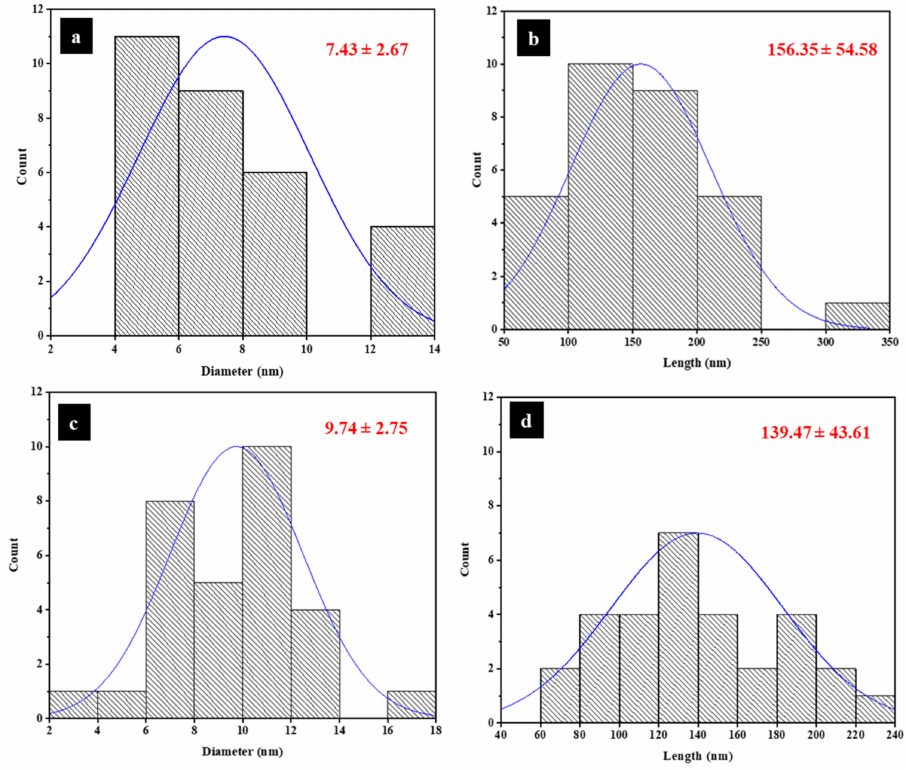
Figure 6. Diameter and length distribution of CNCs under different APS concentrations at 70 ◦ C for 16 h: ( a , b ) 1.5 M; ( c , d ) 1.9